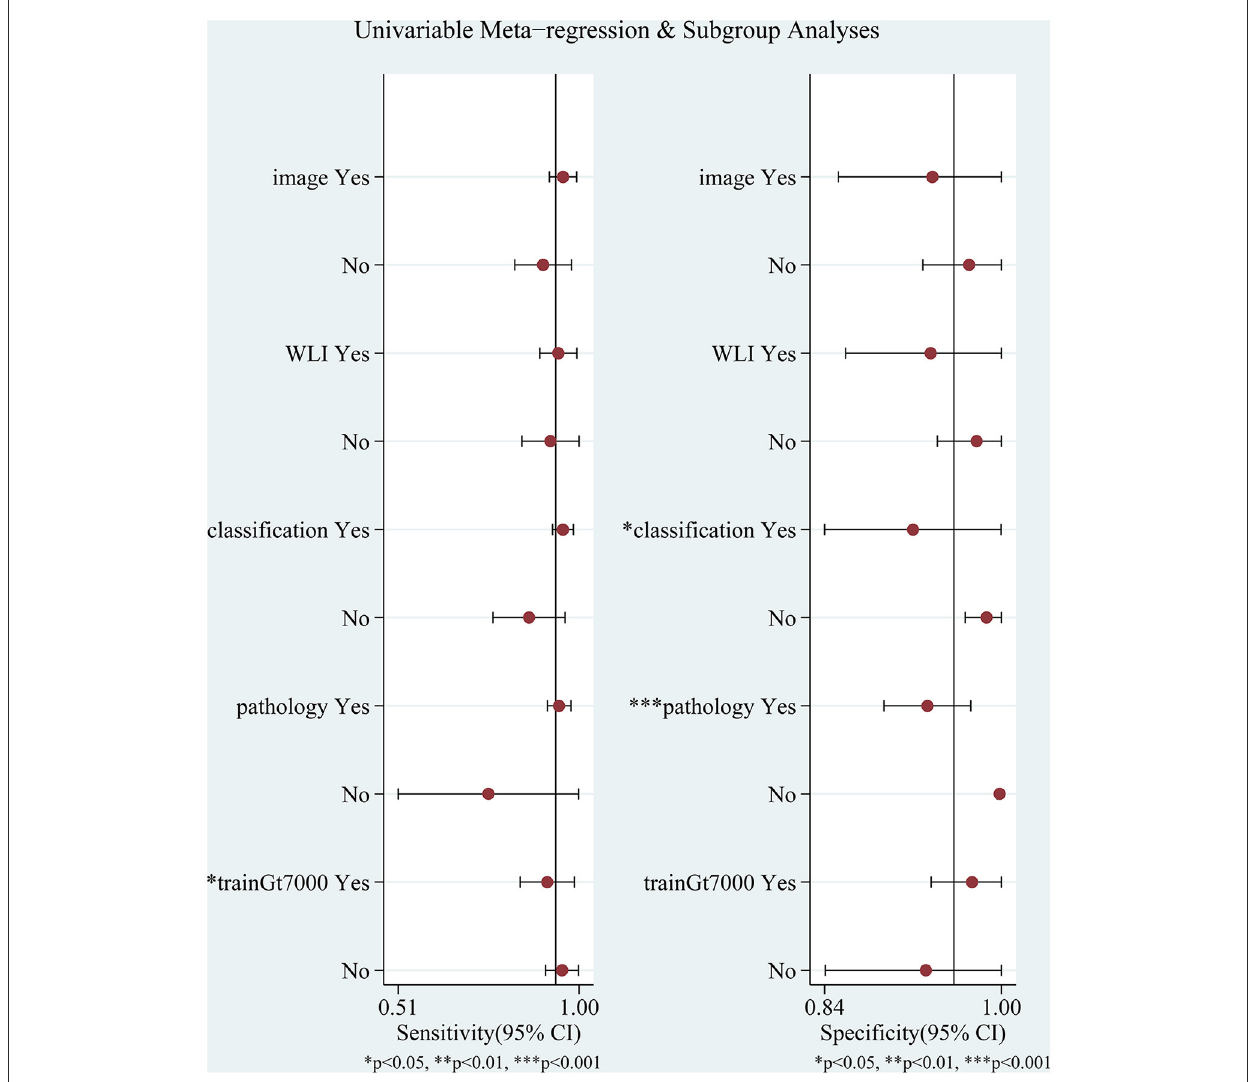
FIGURE7 Meta-regression and subgroup analyses for potential sources of heterogeneity. WLI: endoscopic imaging type is WLI or other; image: test set as image or video; classification: AI algorithm an image classification algorithm or other algorithms; pathology: whether to use pathology as a diagnostic criterion; trainGt7000: whether the number of images was greater than